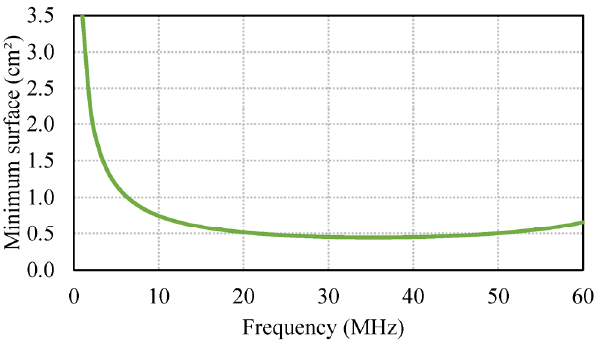
Figure 6. Minimum LNO area to provide 1 A of useful current under 20 V according to the frequency.